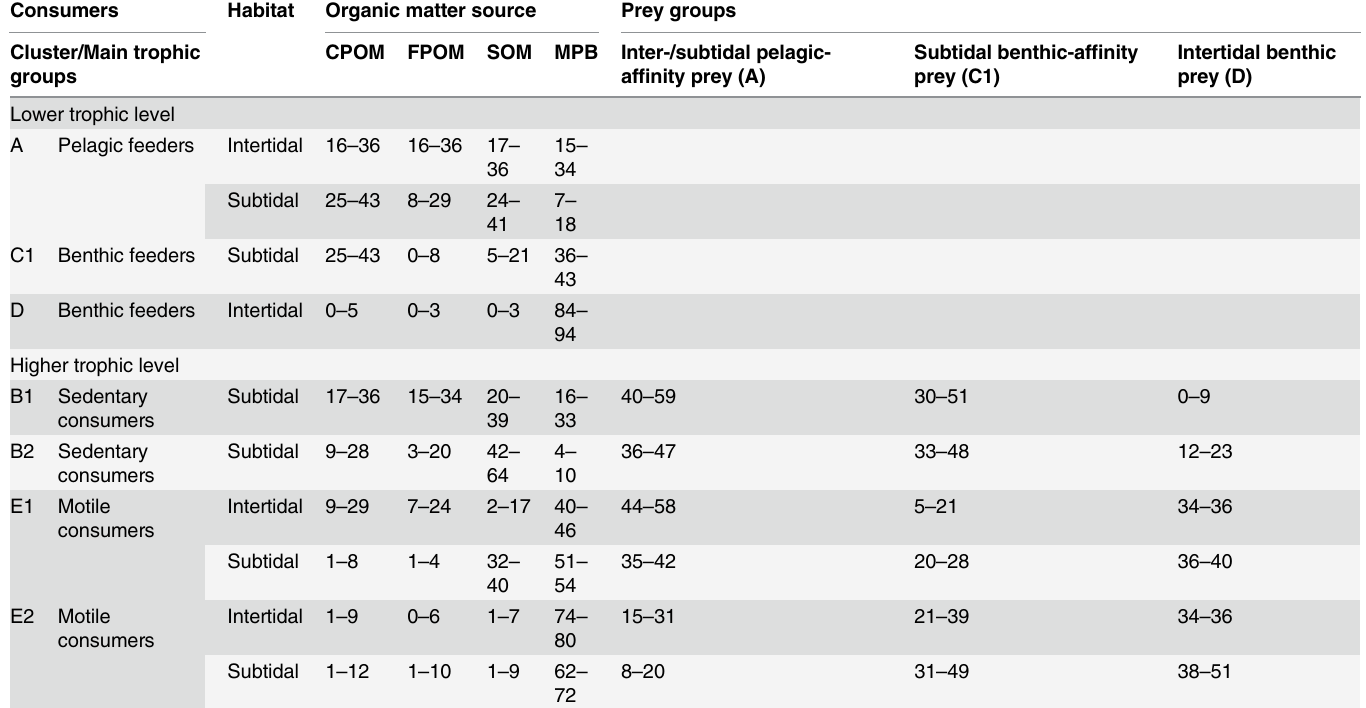
Table 2. The 95% credibility intervals of trophic contribution (%) of organic matter sources or prey groups to the diet of the consumer groups.